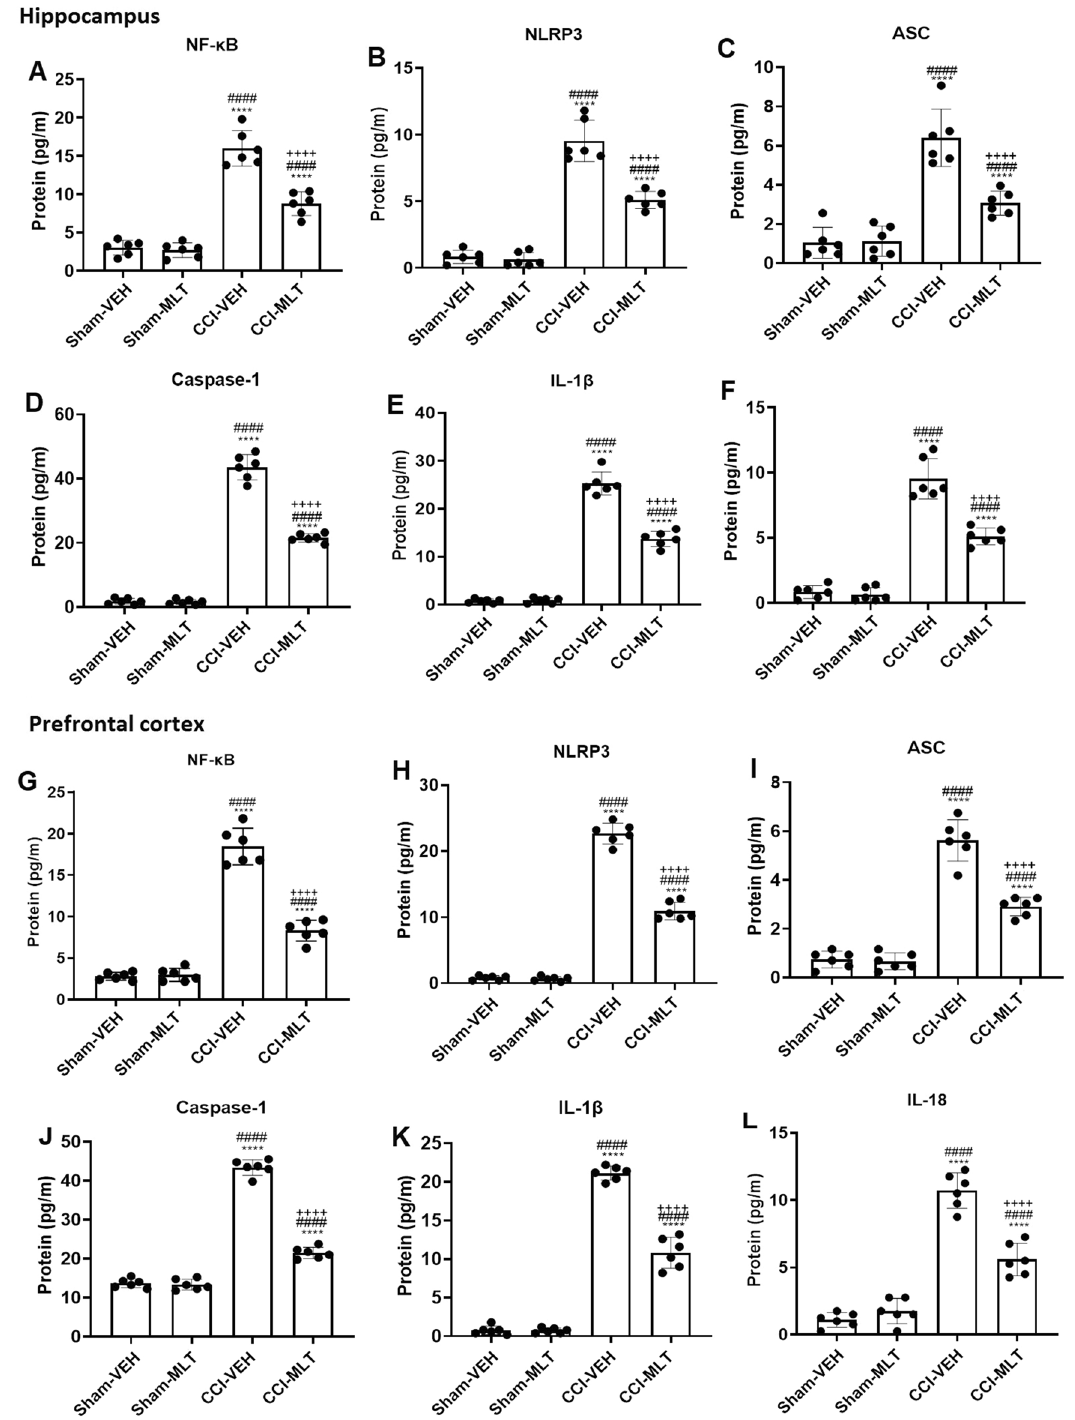
Figure 3. Effects of melatonin (MLT) on the protein levels of ( A,G ) nuclear factor-κB, ( B,H ) NLRP3, ( C,I ) ASC, ( D,J ) Caspase-1, ( E,K ) IL-1β and ( F,L ) IL-18 in the hippocampus and prefrontal cortex of chronic constriction injury (CCI)-induced rats. **** P < 0.0001 compared with the Sham-VEH group; #### P < 0.0001 compared with the MLT group, and ++++ P < 0.0001 compared with the CCI-VEH group. Sham-VEH: sham- operated animals, Sham-MLT: sham-operated animals MLT (10 mg/kg), CCI-VEH: pain-induced animals, and CCI-MLT: pain-induced animals received MLT (10 mg/kg), mean ± standard deviation, n = 6 per